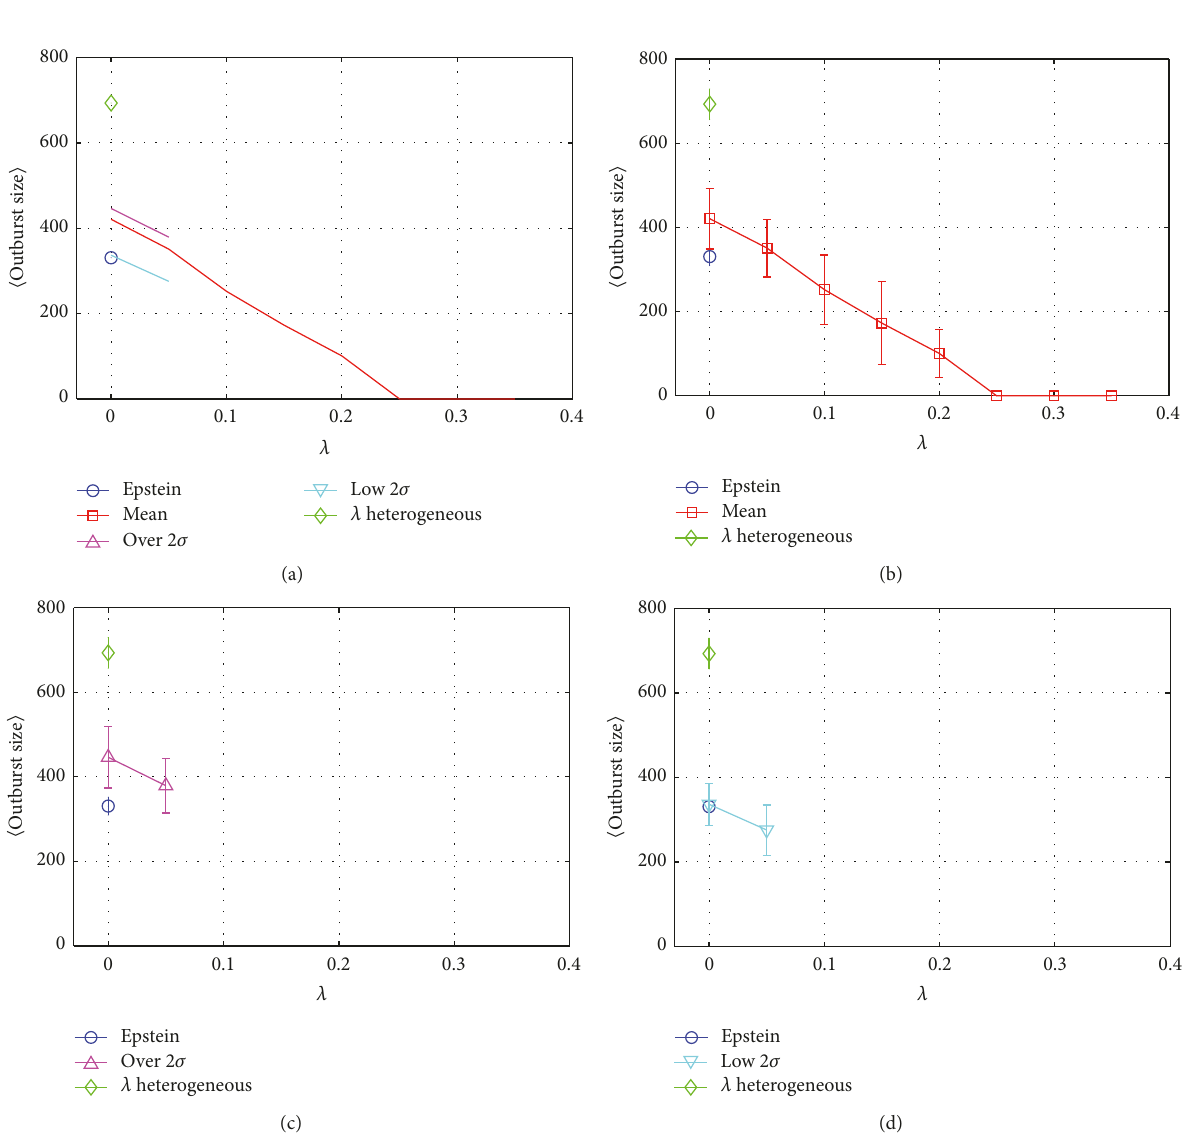
Figure 8: (a) The outburst sizes depending on the savings. The lines with red squares show the average value of the size of the outburst in the range [−2𝜎 𝜆 , 2𝜎 𝜆 ] , where 𝜎 𝜆 is the standard deviation of the maximum values of the outburst sizes for each value of 𝜆 . The magenta and cyan lines show the average value of the size of the outbursts above and below the range [−2𝜎 𝜆 ,2𝜎 𝜆 ] , respectively. The blue circle corresponds to the average size of the outbursts obtained for the Epstein model and the diamond the average size of the outbursts obtained with heterogeneous lambda. In Figures (b), (c), and (d) the average value of the size of the outbursts with their corresponding error bars, obtained both in the range [−2𝜎 𝜆 , 2𝜎 𝜆 ] and over and under the range,